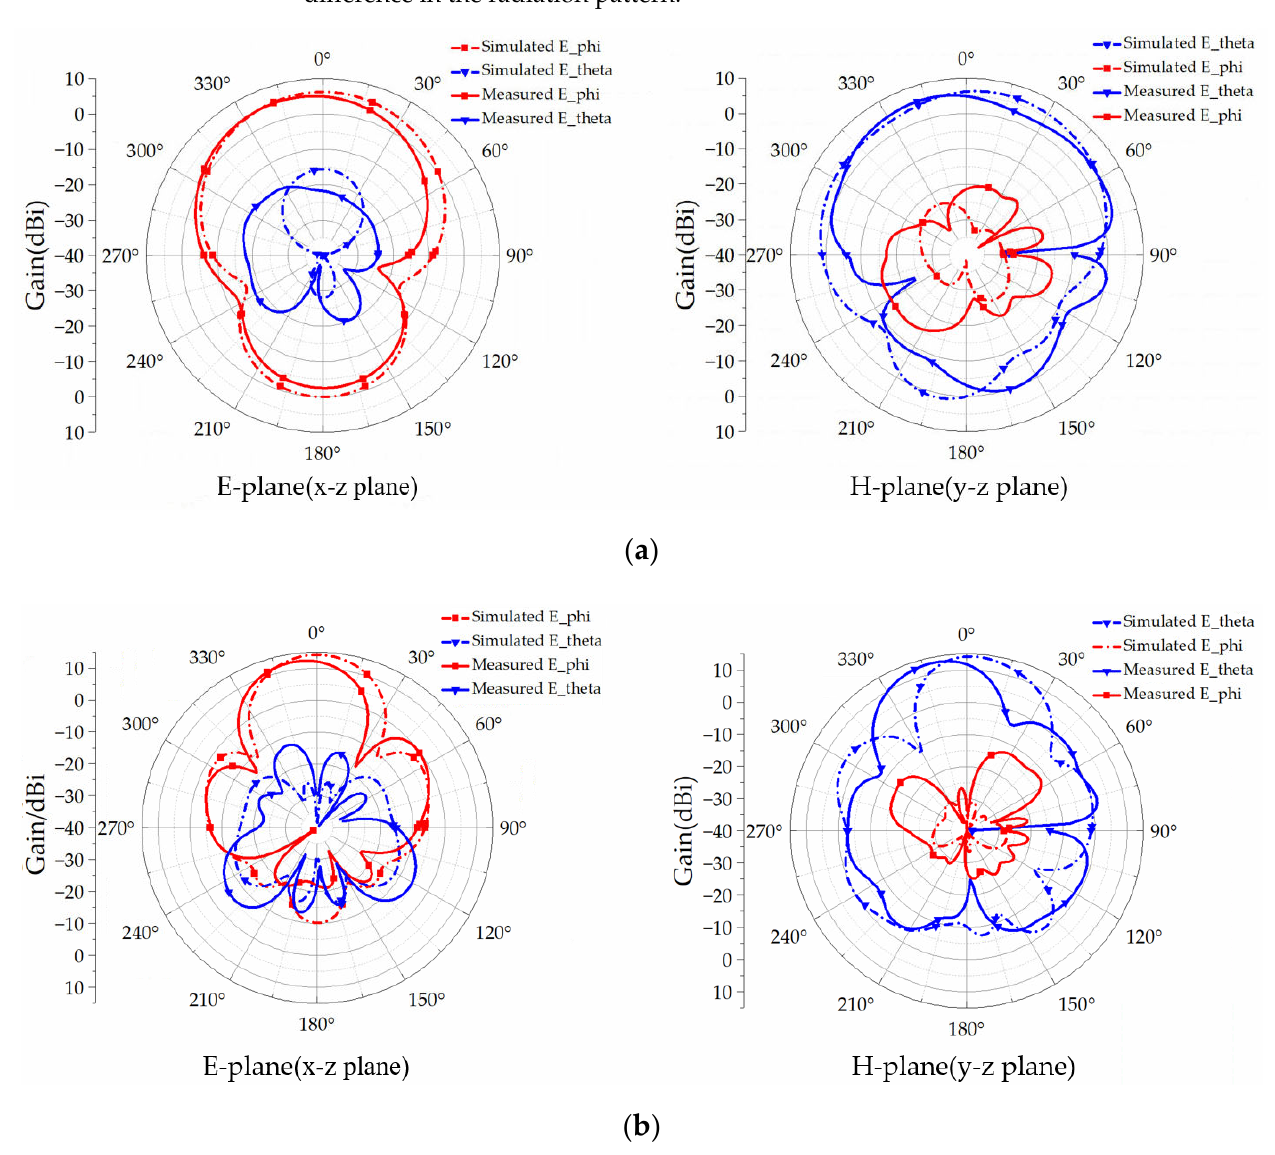
Figure 8. Simulated and measured radiation patterns of the proposed DRA array: ( a ) 2.45 GHz; ( b ) 5.8 GHz.